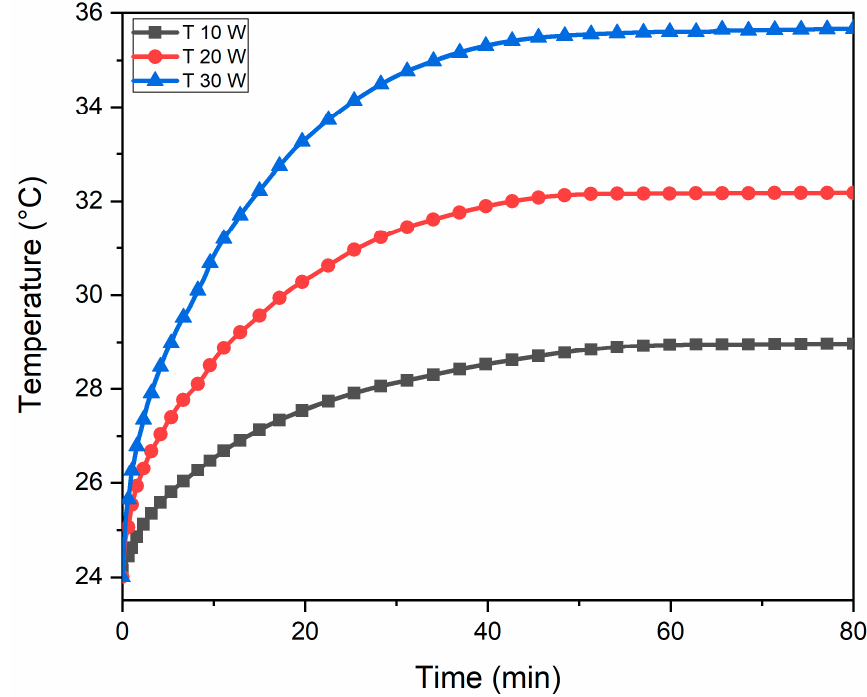
Figure 20. Effect of varying power level on reverse flow configuration.